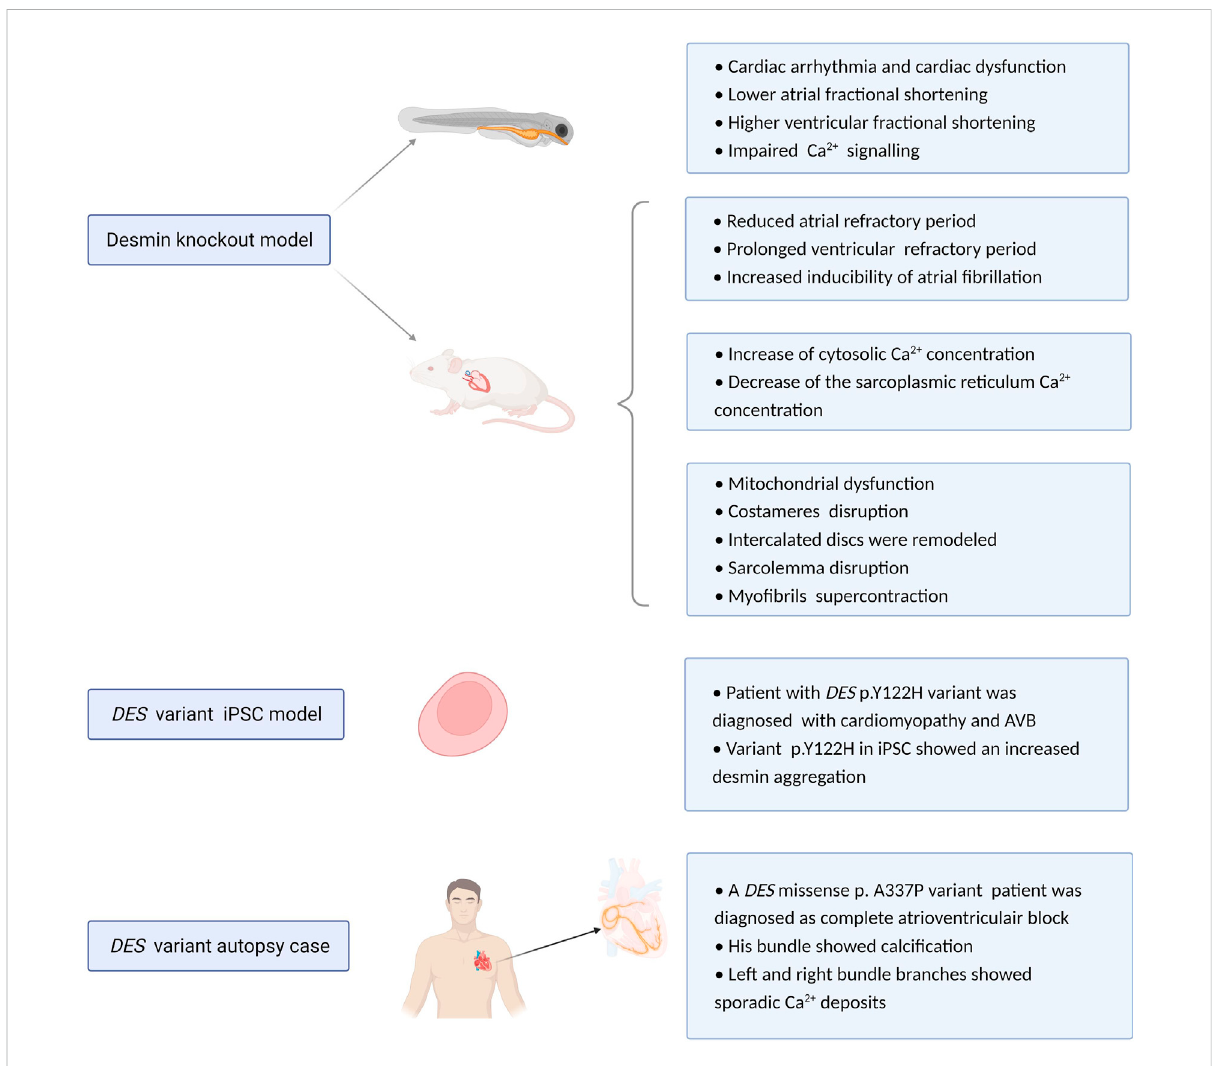
FIGURE 4 Overview potential pathophysiological mechanisms related to DES variants or loss. Experimental desmin knockout and variant model systems reveal a role for desmin impairment in development of cardiac conduction defects and arrhythmias. Proposed mechanism of action is via altered refractory periods, cytosolic Ca 2+ concentrations, loss in desmin network, protein aggregation, and calci fi